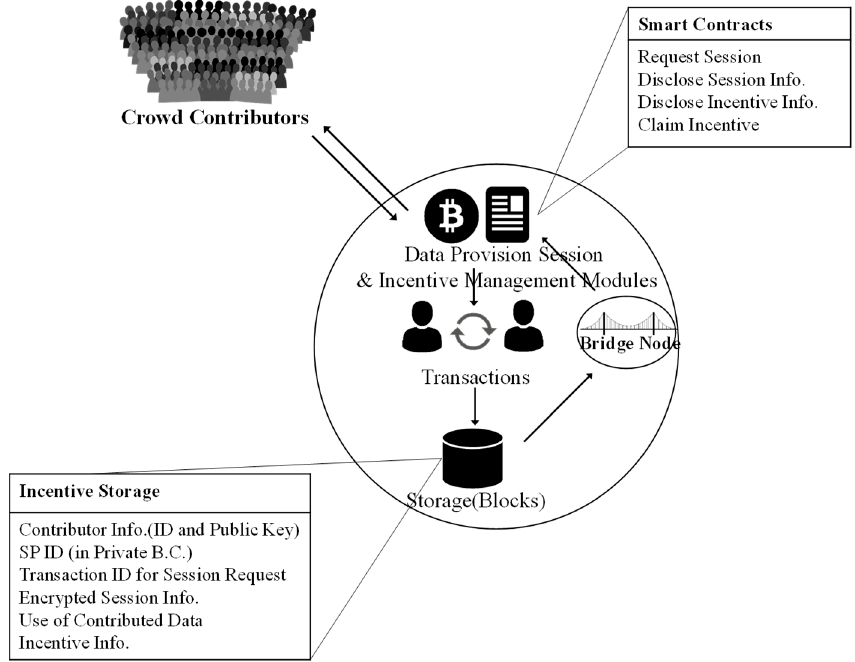
Figure 4. Structural diagram of a public blockchain.